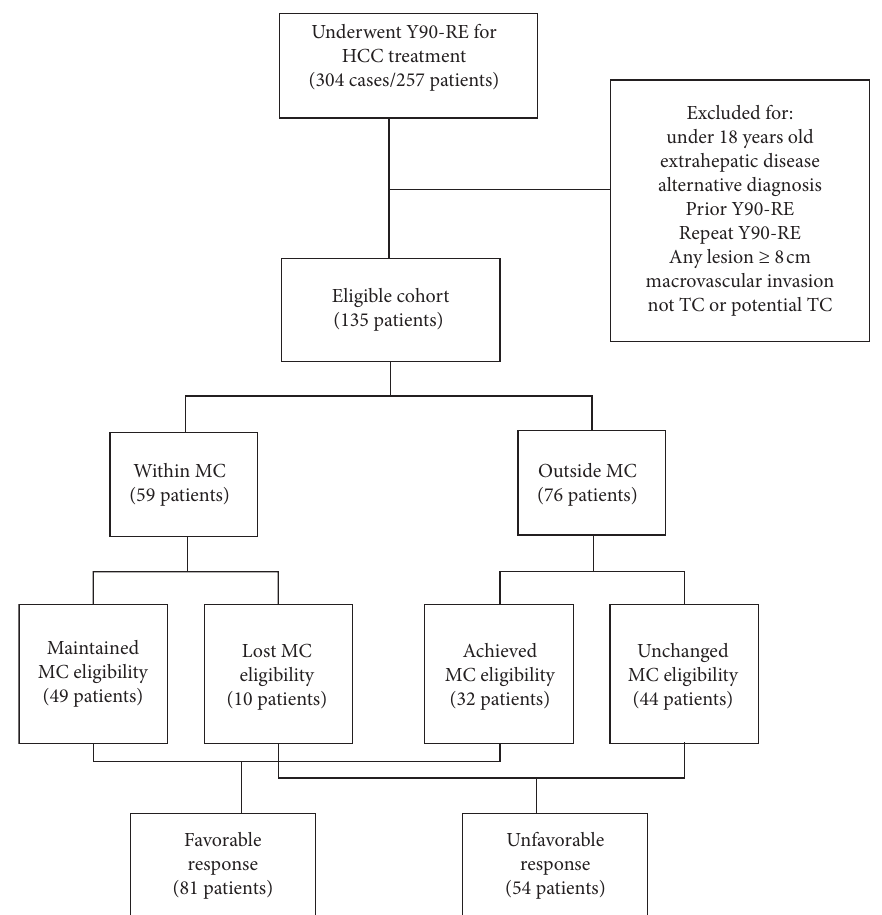
Figure 1: Cohort flowchart. MC � Milan criteria; HCC � hepatocellular carcinoma; TC � transplant candidate; Y90-RE � Yttrium-90